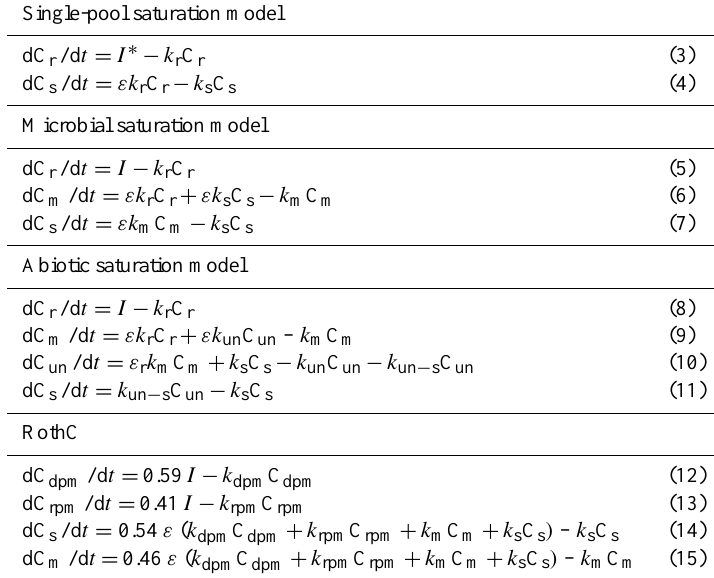
Table 2. Differential equations for carbon pools in each model. Single-pool saturation